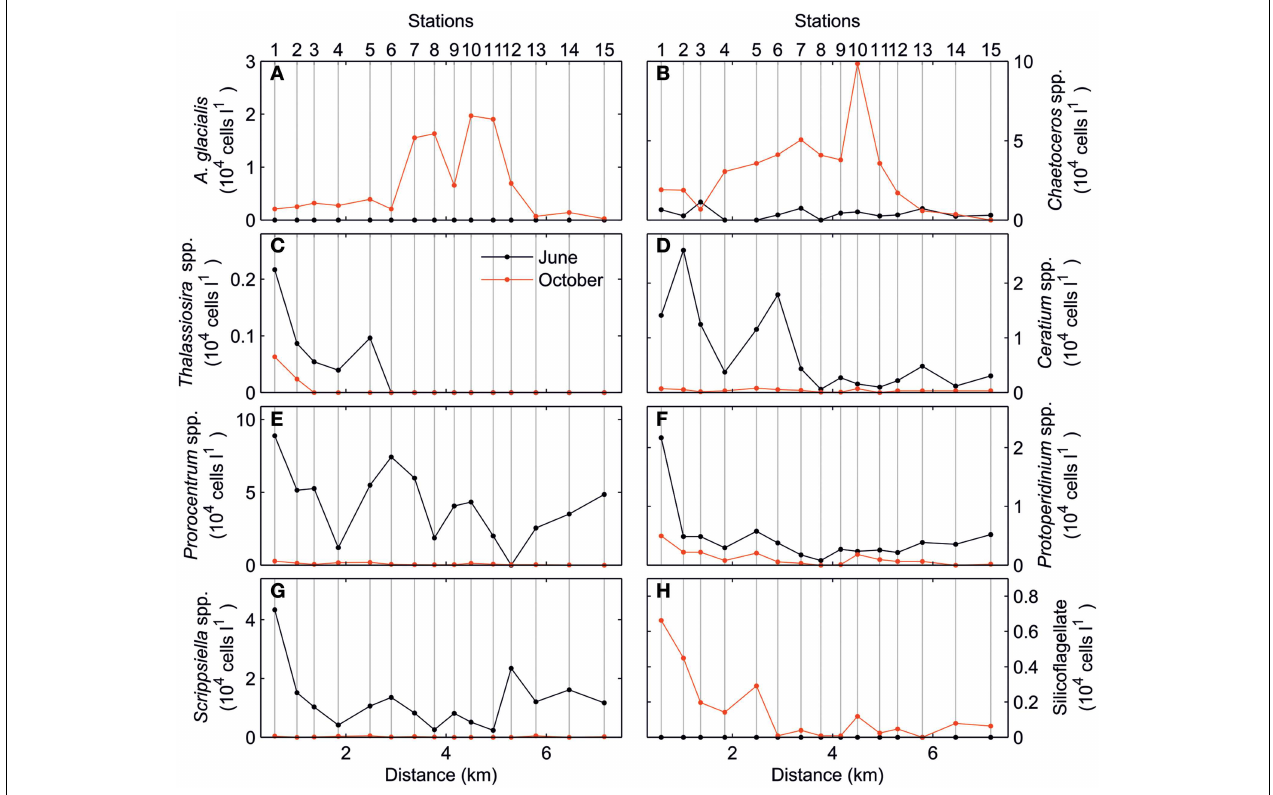
FIGURE 5 | Total cell abundance (10 4 cells l − 1 ) of (A) Asterionellopsis glacialis , (B) Chaetoceros spp., (C) Thalassiosira spp., (D) Ceratium spp., (E) Prorocentrum spp., (F) Protoperidinium spp., (G) Scrippsiella spp., and (H) Silicoflagellate for June (black) and October (red)